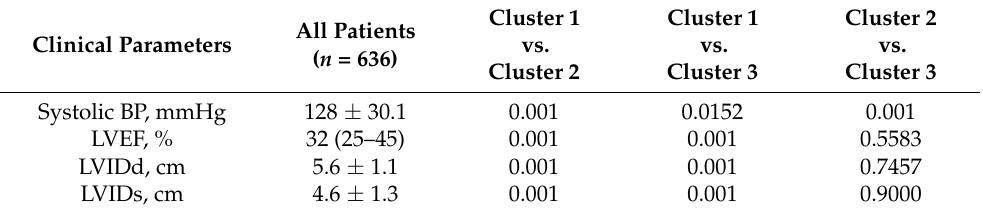
Table 5. Post hoc analysis (showing p -values) of clinical parameters in the study patients stratified according to